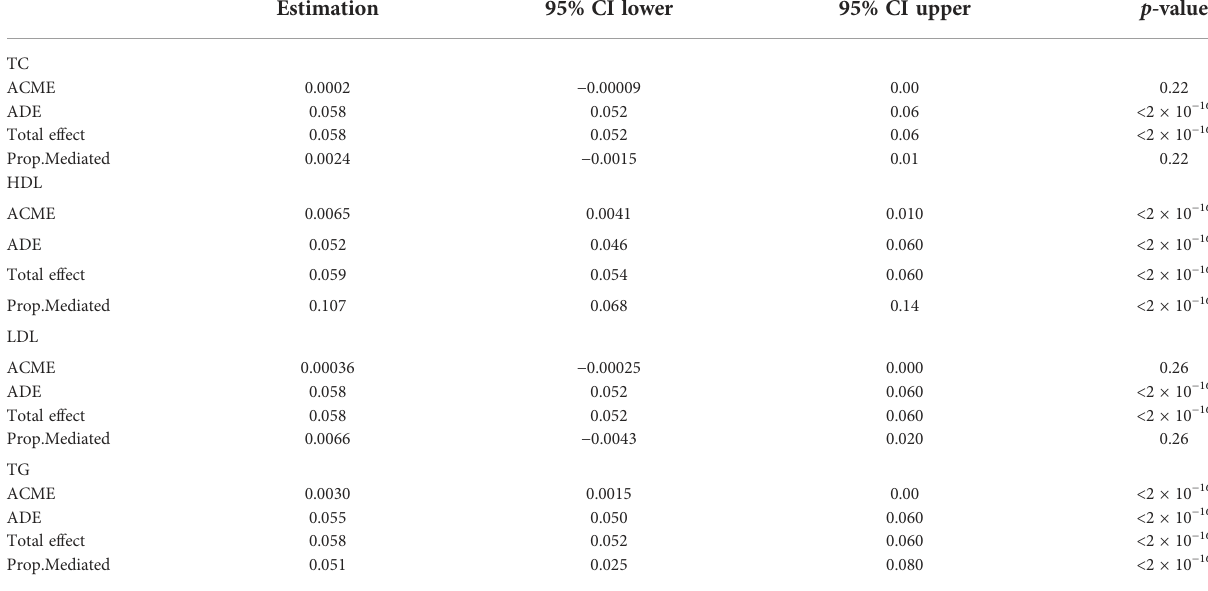
TABLE 3 The sensitivity of observational mediation analysis.